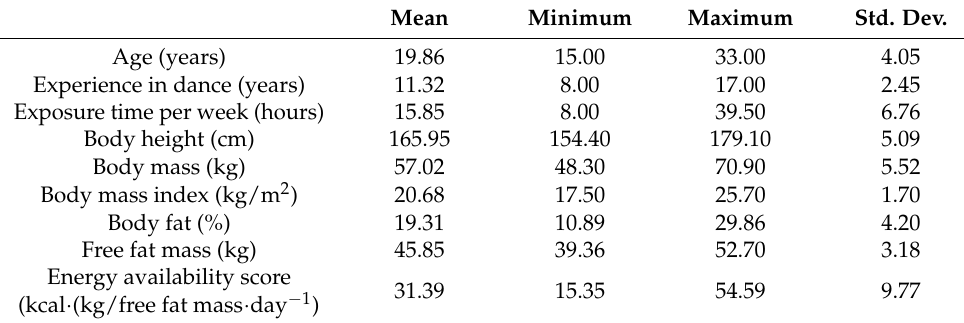
Table 1. Descriptive statistics for independent variables.